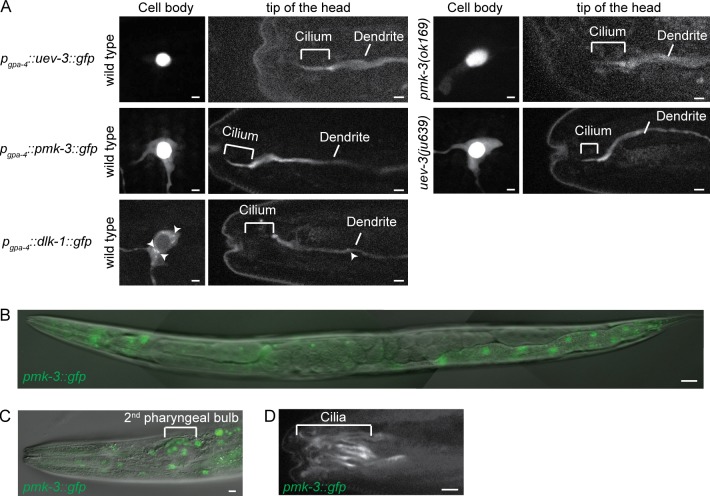
UEV-3, PMK-3 and DLK-1 localization.(A) Fluorescence images of animals expressing either GFP-tagged UEV-3, PMK-3 or DLK-1 in ASI neurons. Arrowheads indicate DLK-1 positive foci. Scale bar 1 μm. (B) Merge of DIC and fluorescence images revealing ubiquitous expression of PMK-3::GFP, expressed from its endogenous promoter. Scale bar 20 μm. (C) Merge of DIC and fluorescence images showing PMK-3::GFP localization in neurons around the 2nd pharyngeal bulb. Scale bar 2 μm. (D) Fluorescence image of PMK-3::GFP localization in cilia of amphid channel neurons. Scale bar 2 μm. Anterior is to the left.